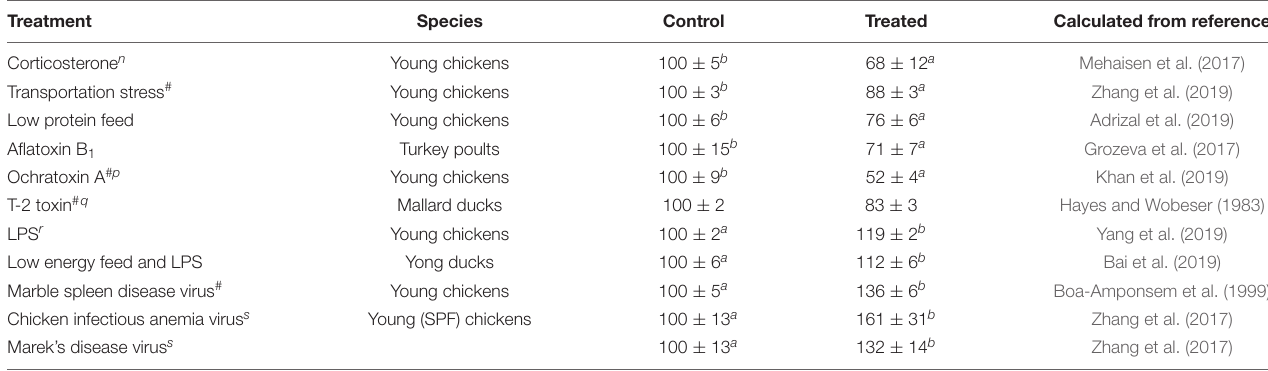
TABLE 6 | Effect of challenges on spleen weights or relative spleen weights (data is expressed as the percentage of the control ± SEM).